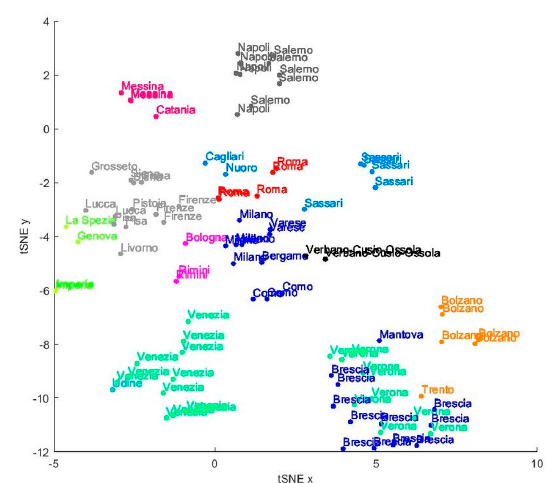
Figure 7. t-SNE reduction of the 100 most visited locations labeled as the province and colored as the region they belong to.